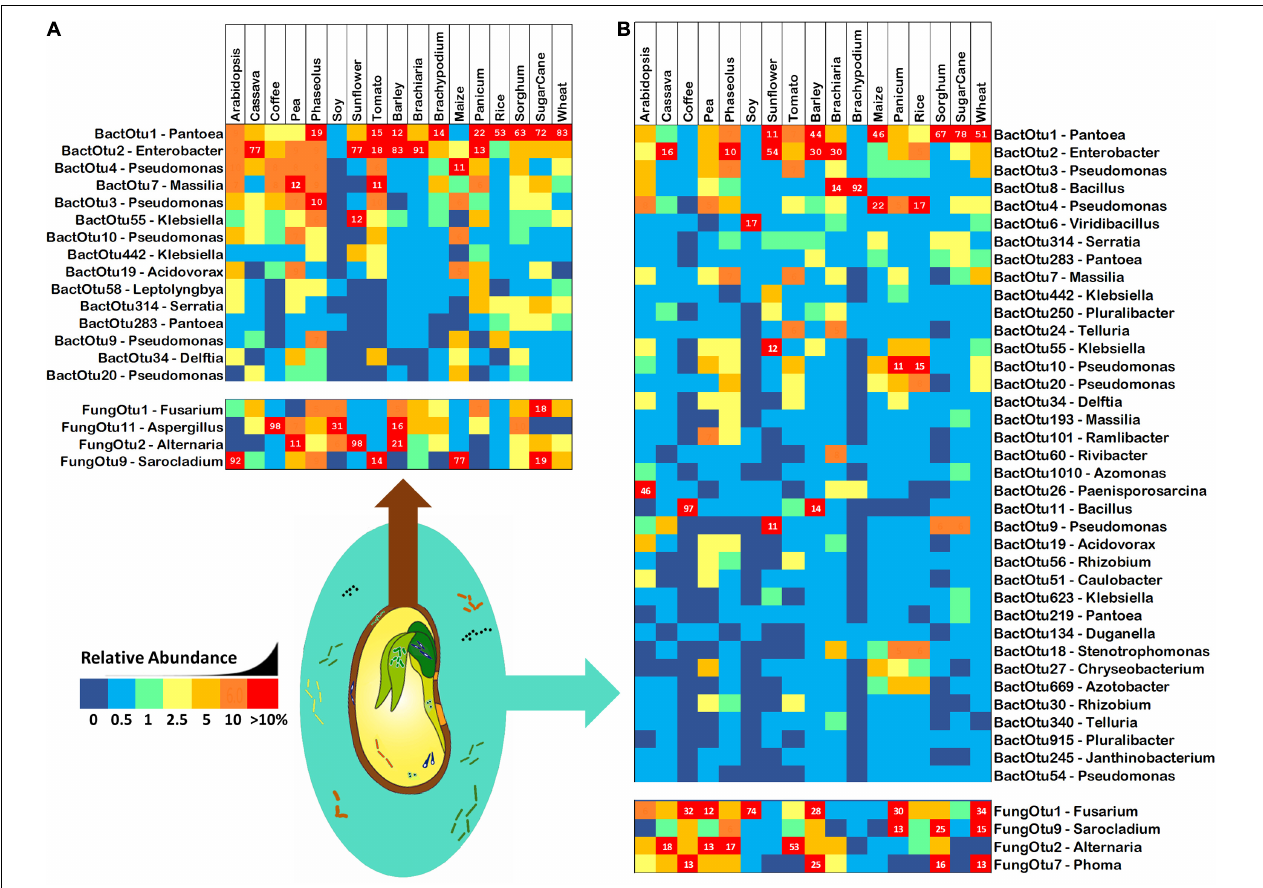
FIGURE 3 | Common bacterial 16S and fungal ITS OTUs of (A) seeds and (B) spermospheres. Common OTUs were defined as having an occupancy of more than 60% across seeds or spermospheres of the 17 different plant species. Bacterial OTUs are shown in the top blocks, fungal OTUs on the bottom blocks. Next to each OTU ID# is the predicted genus of that sequence. OTU read proportion is represented by color as shown in the legend, with red squares also showing the proportion as a